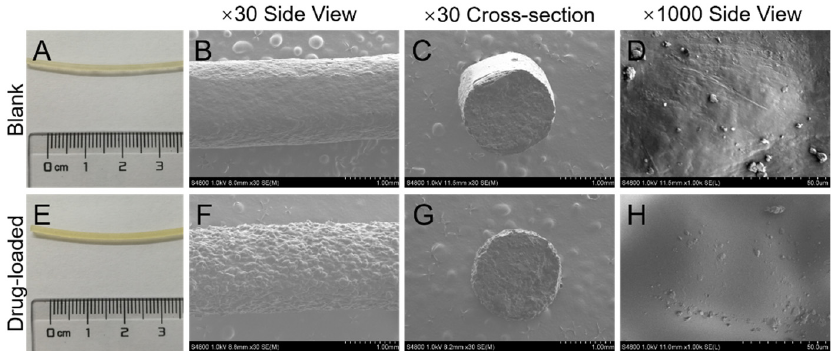
Figure 5. SEM section view ( A – E ) and corresponding photographs ( F – J ) of the formulations. 3.2. X-ray Powder Diffraction The result of XRD is shown in Figure 6. The pure verapamil hydrochloride showed several characteristic peaks at 2 θ of 10.61°, 14.50°, 17.09°, 18.09°, 18.86°, 20.20°, 21.32°, 23.09°, 23.79°, and 26.35°, which was close to the literature reports that the prominent peaks from pure verapamil hydrochloride were observed at 2 θ of 10.59°, 14.45°, 17.07°, 18.1°, 18.84°, 20.29°, 21.32°, 23.06°, 23.75°, and 26.29° [25,35]. The HPMC and Soluplus ®